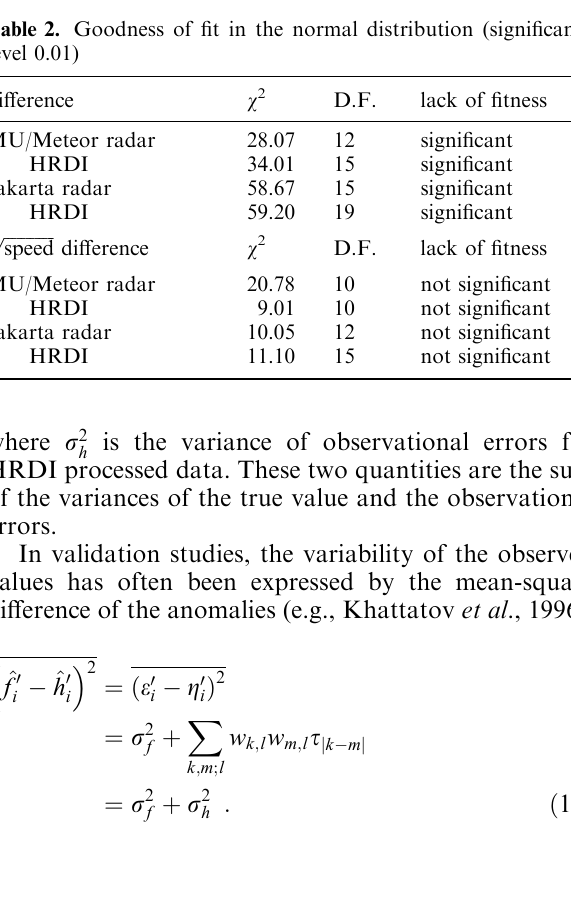
Fig. 7. Distributions of the speed and corresponding nor- mal distribution functions for HRDI and radars. Top : raw values, bottom : values after ta- ken by